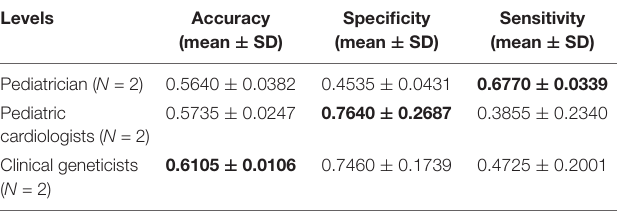
Values in bold indicate the optimal performance. SD, standard